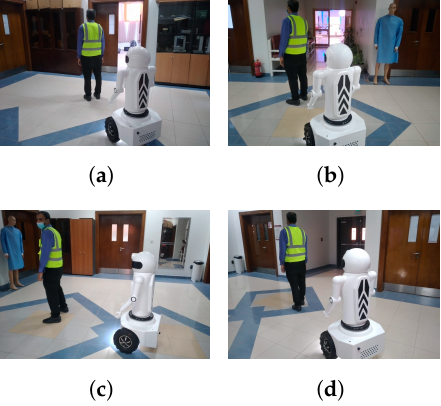
Figure 29. Following scenes: ( a–d ) different light conditions.